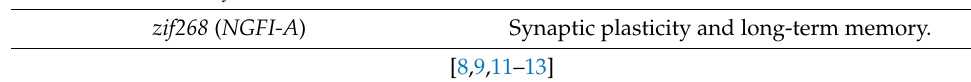
Table 1. Cont. IEGs Function Stra13 zf9